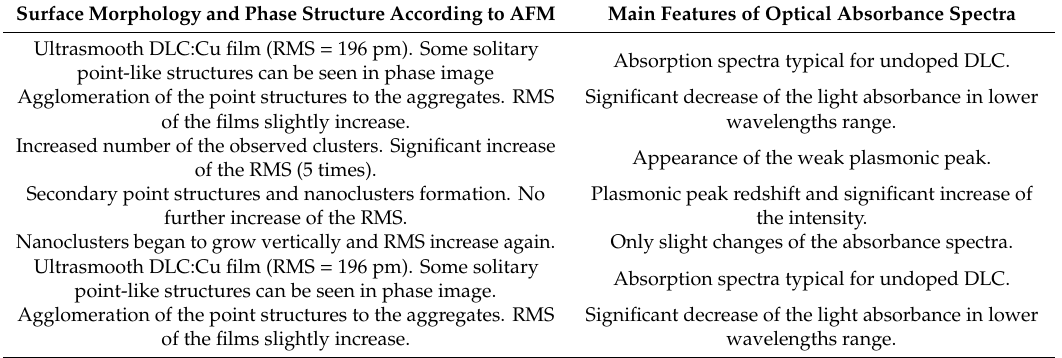
Table 2. Correlation between the changes of the DLC:Cu films surface morphology as well as phase structure and the optical absorbance spectra of the